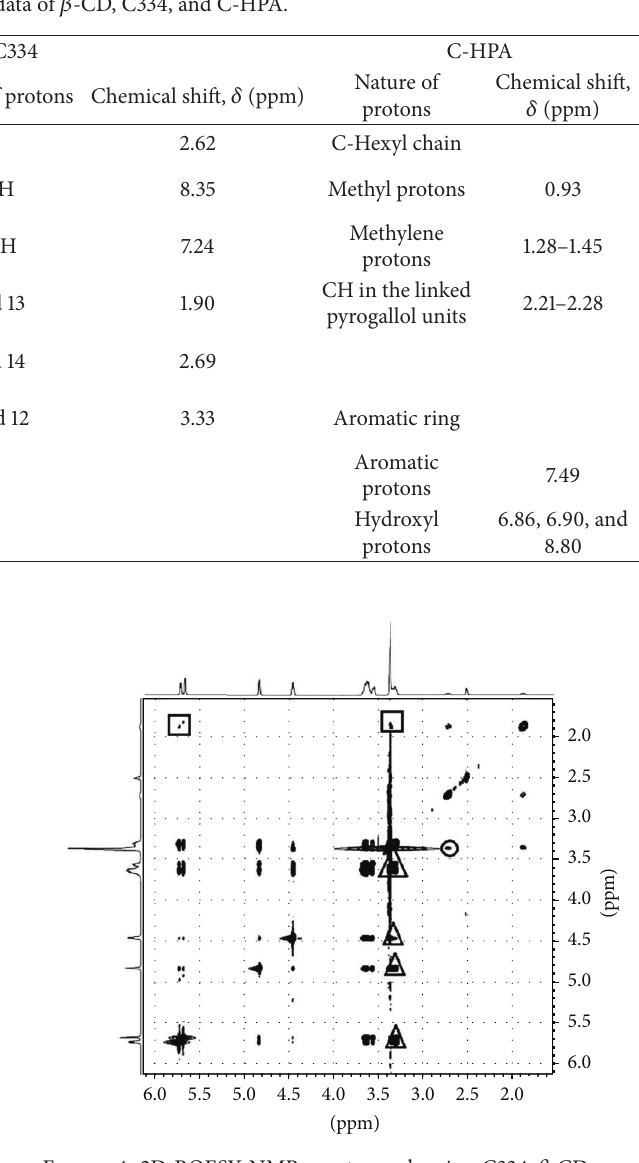
Figure 4: 2D ROESY NMR spectrum showing C334- 𝛽 -CD com-